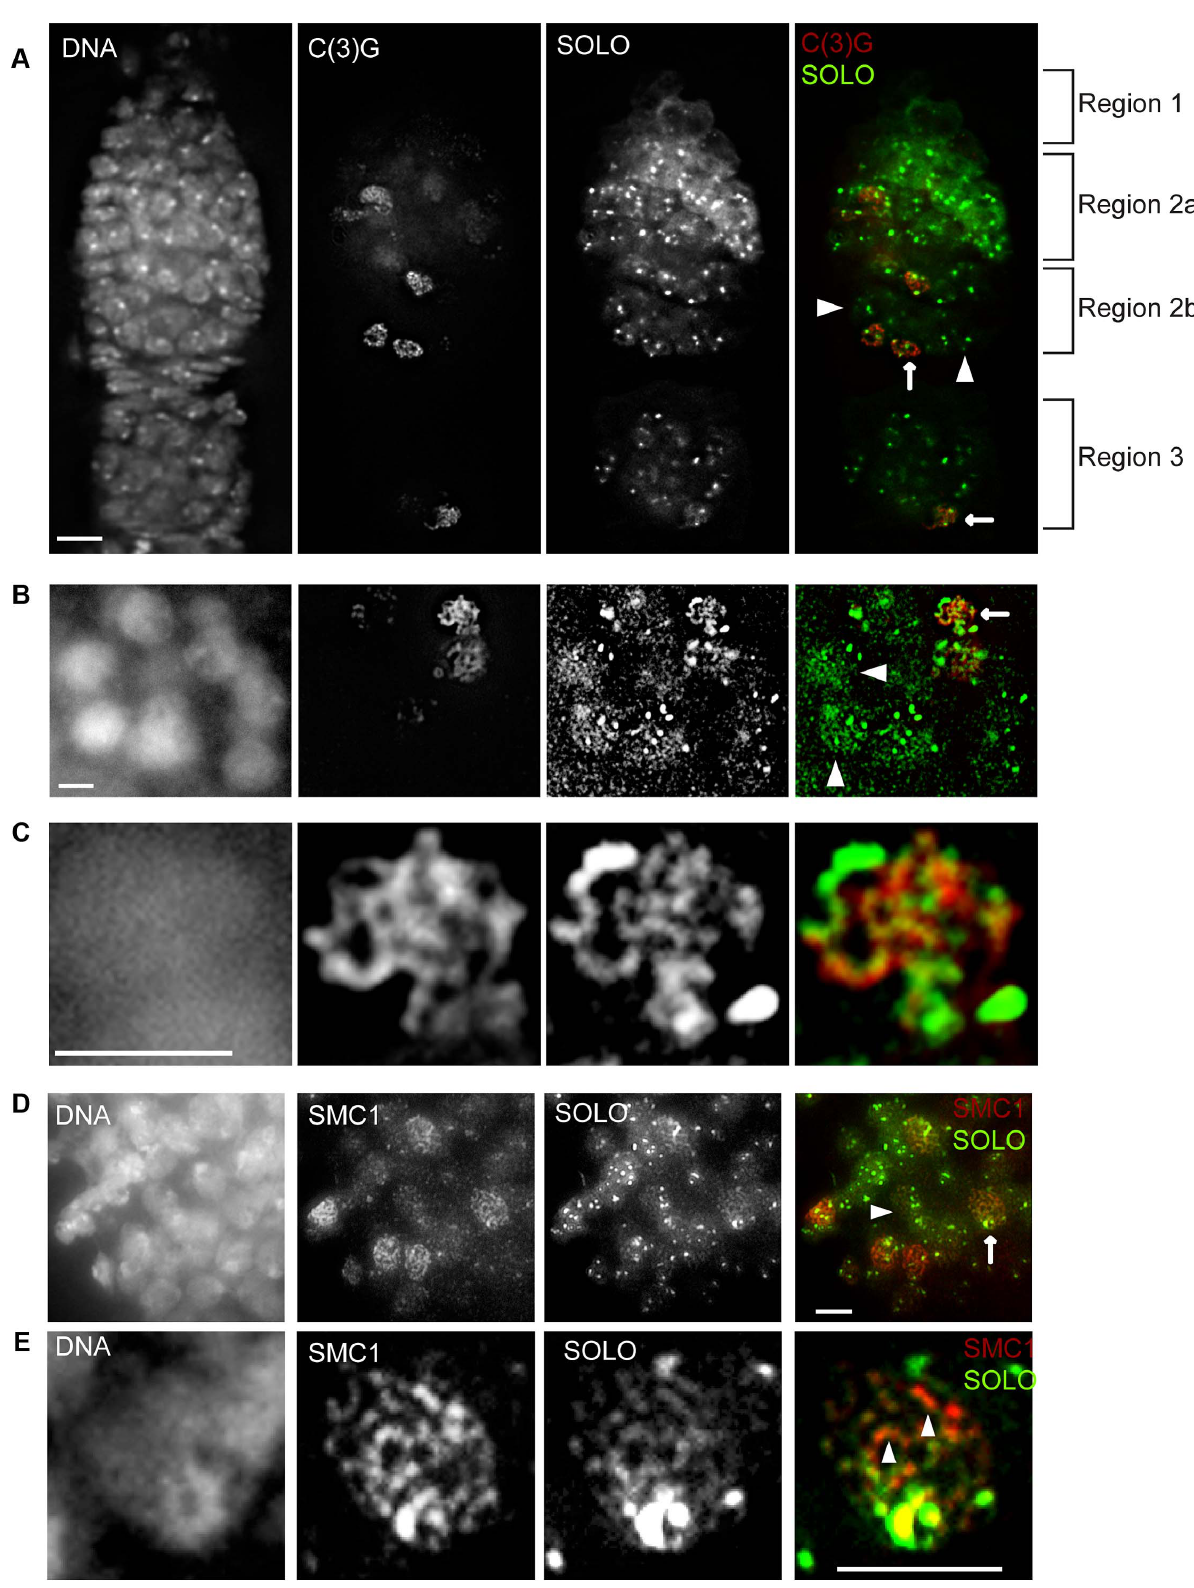
Figure 4. SOLO co-aligns with C(3)G and SMC1 on chromosome arms in pro-oocytes and oocytes. Expression of Venus::SOLO was induced by nos-GAL4::VP16 in Df(2L)A267/solo Z2-0198 ; {UASp-Venus::SOLO}/{nos-GAL4::VP16} females and stained with anti-GFP antibody. SC was visualized by anti-C(3)G staining and DNA was stained with DAPI. Scale bars: 5 m m. (A) SOLO and C(3)G staining in a whole-mount germarium.